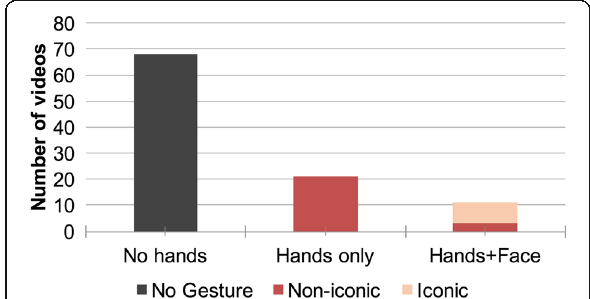
Fig. 5 Number of videos in which hands and faces were seen and the different types of gestures that were